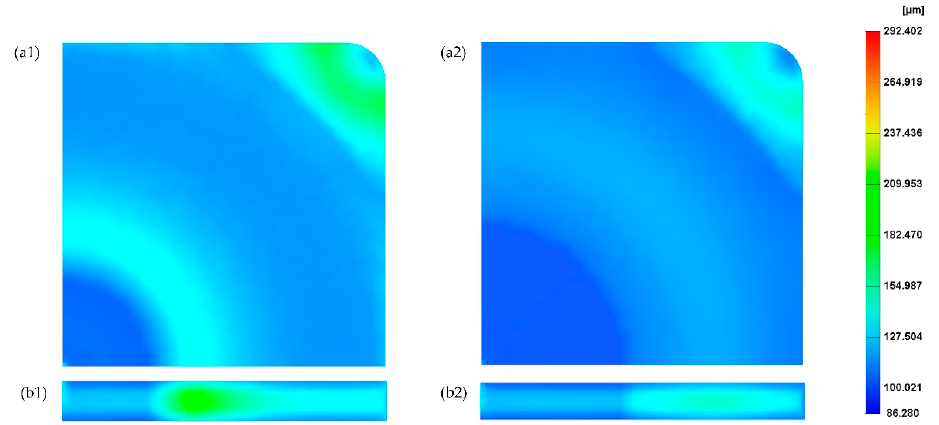
Figure 16. The cell distribution on the part considering an injection pressure of 10 MPa ( a1 , b1 ) and 30 MPa ( a2 , b2 ).